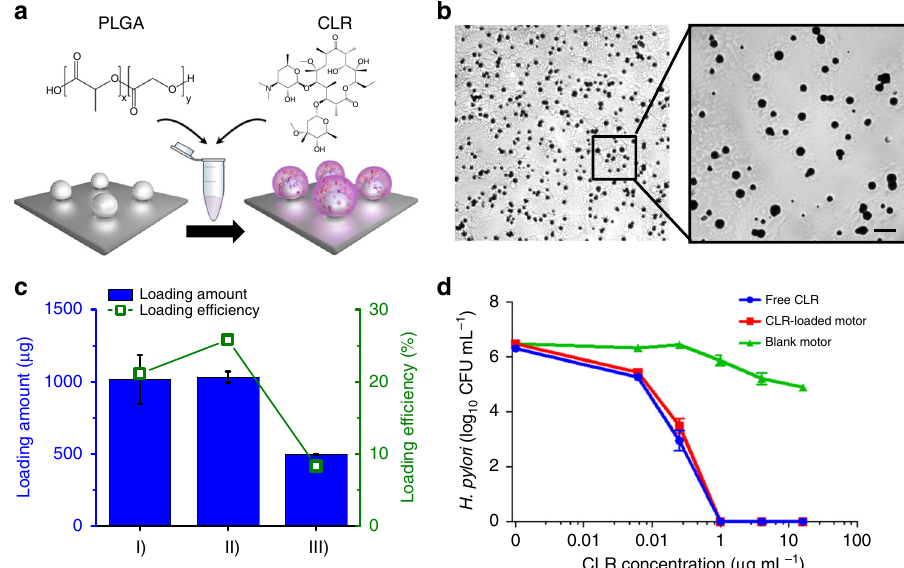
Fig. 2 Antibiotic drug loading of the Mg-based micromotors and in vitro bactericidal activity. a Schematic displaying the loading clarithromycin ( CLR ) onto the Mg-based micromotors. PLGA polymer dissolved in ethyl acetate is mixed with CLR, and the solution is deposited over the Mg-TiO 2 microparticles resulting in the formation of a thin PLGA-CLR coating. b Microscope images showing the PLGA-CLR fi lm over the Mg-based micromotors. Scale bars 100 µ m and 40 µ m, respectively. c Quanti fi cation of CLR-loading amount and yield of the micromotors prepared with different CLR solutions: (I) 100 µ L of 40 mg mL − 1 CLR solution, (II) 120 µ L of 40 mg mL − 1 CLR solution, and (III) 200 µ L of 30 mg mL − 1 CLR solution. All the CLR-loaded Mg-based micromotors were coated with a thin chitosan layer; all samples were dissolved in acid for 24 h before the drug-loading measurement. d In vitro bactericidal activity of free CLR, CLR-loaded Mg-based micromotors, and blank Mg-based micromotors (without CLR drug) against H. pylori bacteria. Error bars estimated as a triple of s.d. ( n =